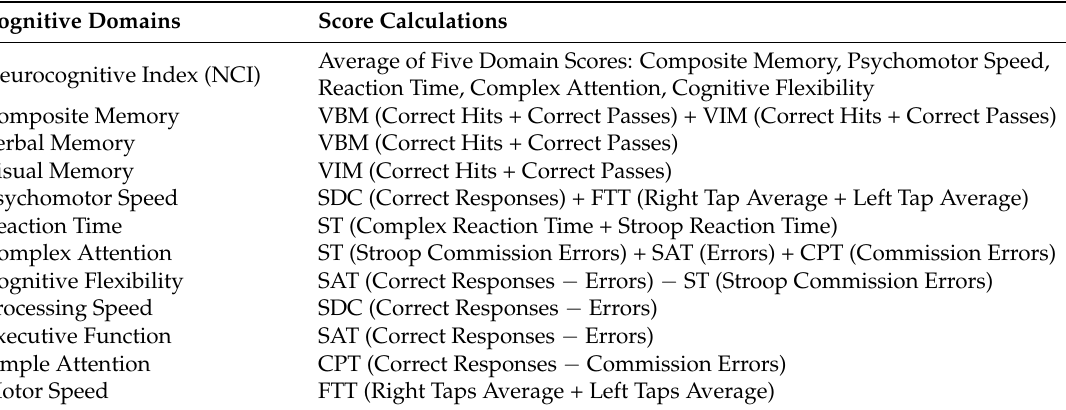
Table 1. Cognitive domain scores estimated using